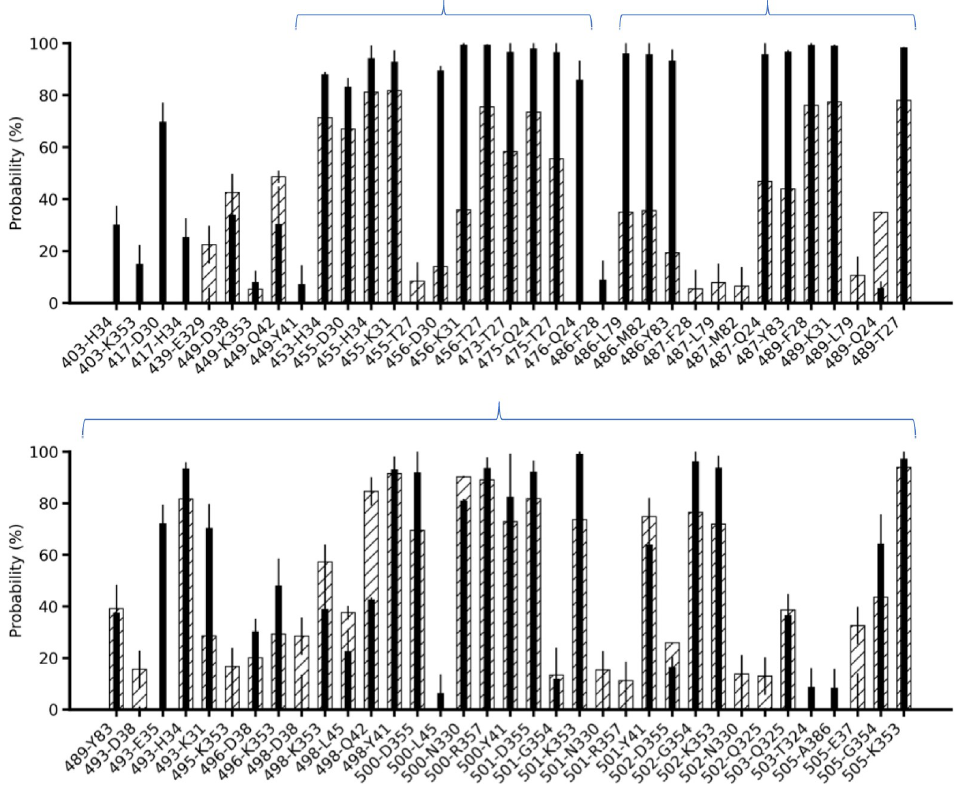
Fig 2. Probability of aligned pairs of residues found within 3.5 Å at the RBD1-ACE2 (shaded bars) and RBD2-ACE2 (black bars) interfaces using C36 FF. The first number corresponds to RBD based on alignment in Fig 1A. A stable pair is defined to have a probability larger than 60% during the simulation times. The clusters of improved interactions in RBD2-ACE2 are marked with